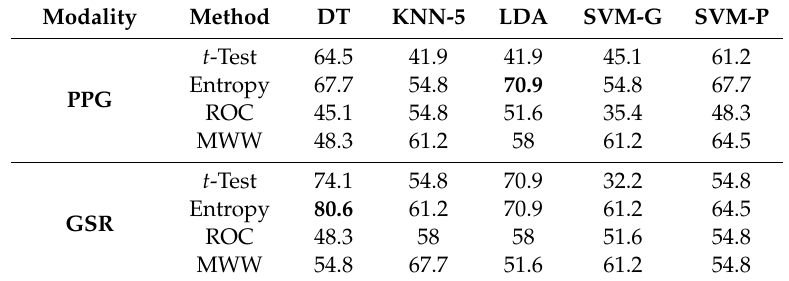
Table 5. Improvement of classification accuracy by employing four feature ranking methods in the mock crime scenario. The results reported by the 10 highest ranked features of thermal